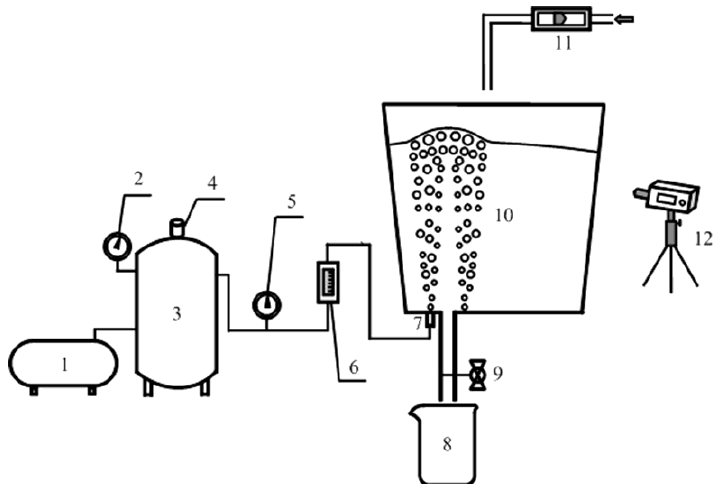
Figure 2. Schematic of the experimental setup: 1. air compressor; 2. pressure gauge; 3. air tank; 4. spring safety valve; 5. gas pressure regulator; 6. gas flow controller; 7. annular porous plug; 8. beaker; 9. ball valve; 10. model ladle; 11. fluid flowmeter; and 12. digital camera.